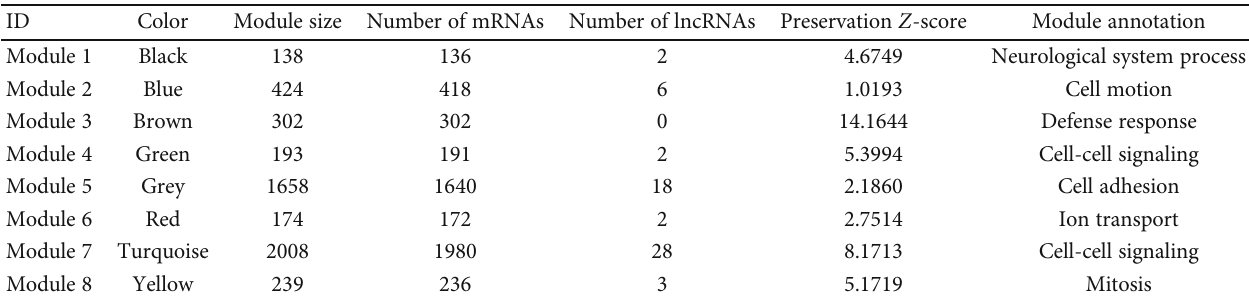
Figure 2: Selection graphs of the soft-thresholding power β in the adjacency matrix (a) and schematic diagram of the mean connectivity of RNA under various power values (b). Table 1: Stable modules screened using weighted gene coexpression network